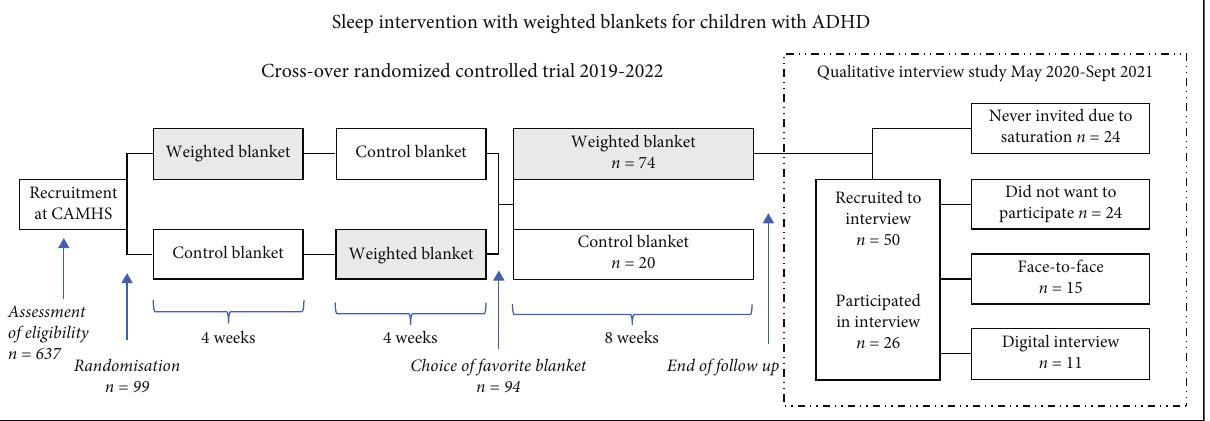
Figure 1: Study design of sleep intervention with weighted blankets and recruitment of participants for interviews. Table 1: Characteristics of the intervention and participating children with ADHD and sleeping di ffi culties. Characteristics of children and